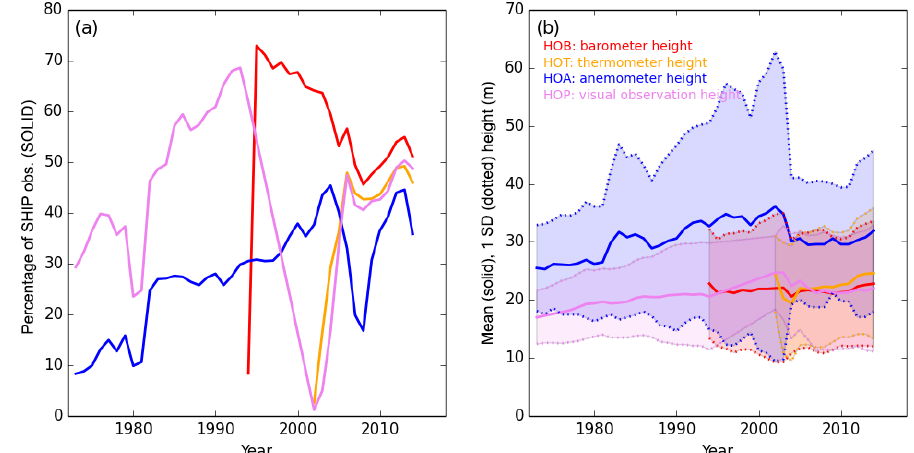
Figure 3. (a) Availability of instrument height information for ships (platform, PT = 0 , 1 , 2 , 3 , 4 , 5) for the barometer (HOB), thermometer (HOT), anemometer (HOA), and visual-observing platform (HOP) with (b) mean heights (solid lines) and standard deviations (dotted lines) for each year. All ICOADS 3.0.0 and 3.0.1 observations passing third-iteration quality control are included.